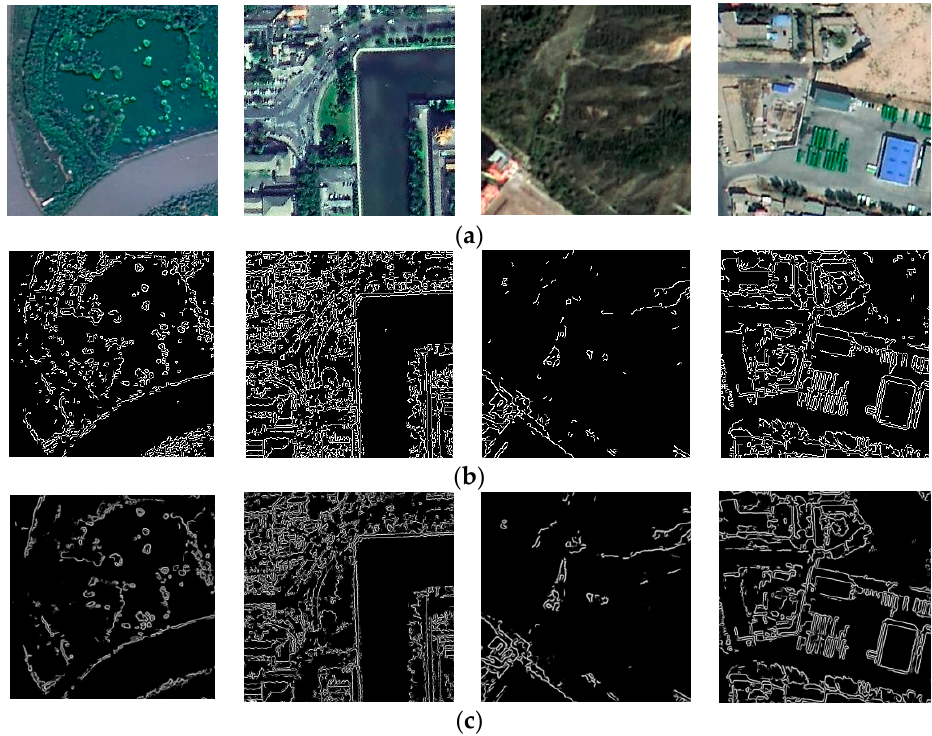
Figure 10. Comparison between the robust features extracted by U-net and the features extracted by Canny operator: ( a ) Examples of the original HRRS images, ( b ) edge detected by Canny operator, (c) robust edge detected by the modified U-net model.